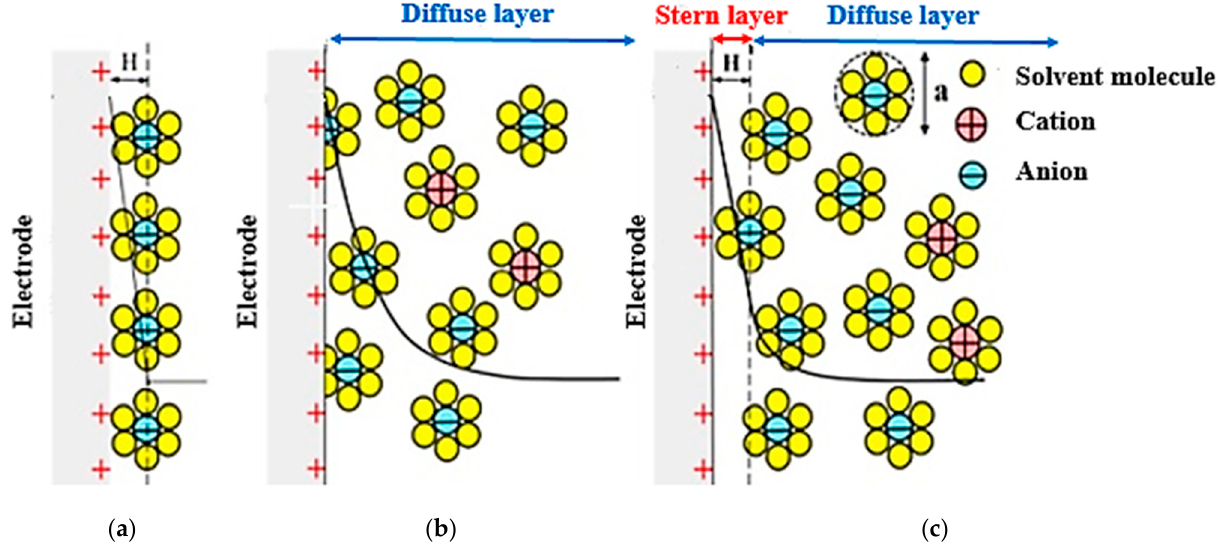
Figure 14. Schematic diagram of how to create Electrical Double Layers. ( a ) Helmholtz model, ( b ) Gouy–Chapman model, and ( c ) the Gouy–Chapman-Stern model. Reprinted/adapted with permission from Ref [62]. 2018, Baroud, T.N.